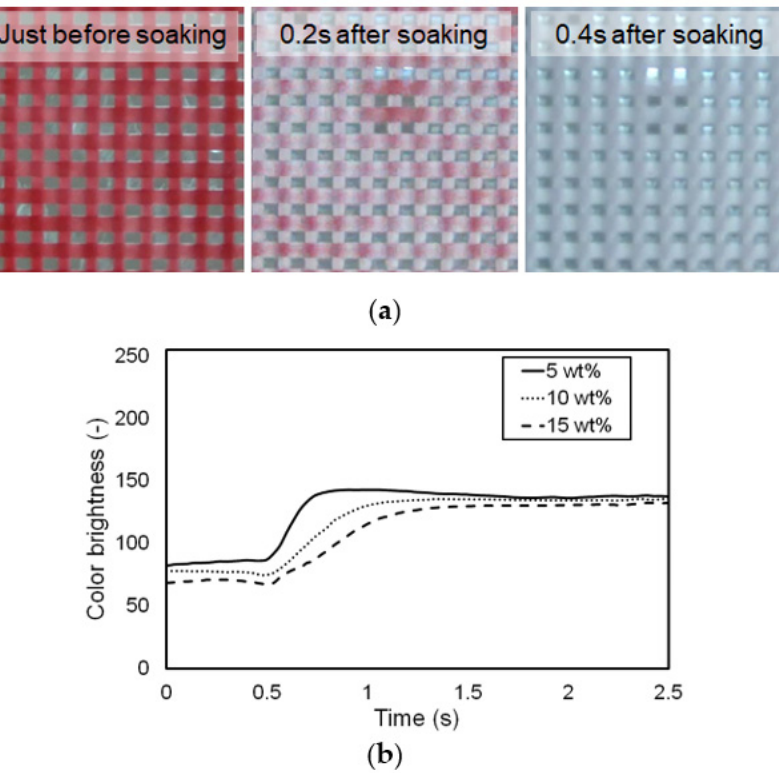
Figure 12. Color change in the fabricated membranes in warm water: ( a ) color change in a membrane with a pigment concentration of 5 wt.%; ( b ) color brightness change behavior of the membranes with three different pigment concentrations when they were soaked from air in warm distilled water (37.5 °C) at an instant of 0.5 s. branes with different concentrations between room temperature and 37.5 ◦ C. At room temperature, the color brightness of a membrane with a high concentration decreased due to the large amount of pigment powder, which made the membrane’s red color dark. Mean- while, the difference in the color brightness of the membranes at a temperature of 37.5 ◦ C was reduced because the powder color became a bright one, that is, close to white. The ob- tained color brightness values are listed in Table 3; their standard deviations were less than 7%, indicating that the fabricated membranes had consistent thermochromic